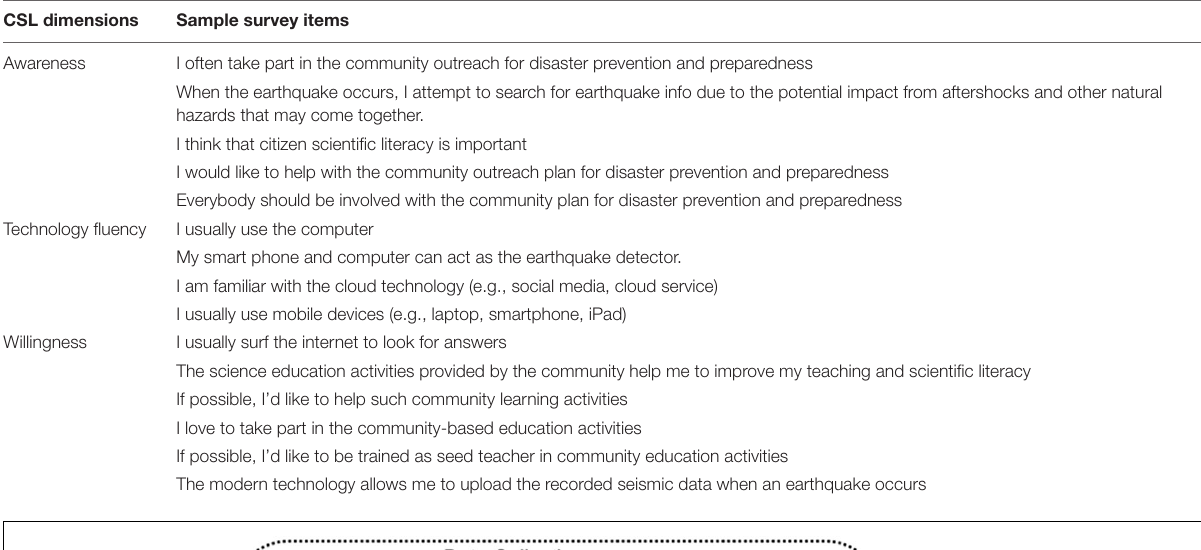
TABLE 1 | Items of citizen seismological literacy survey.